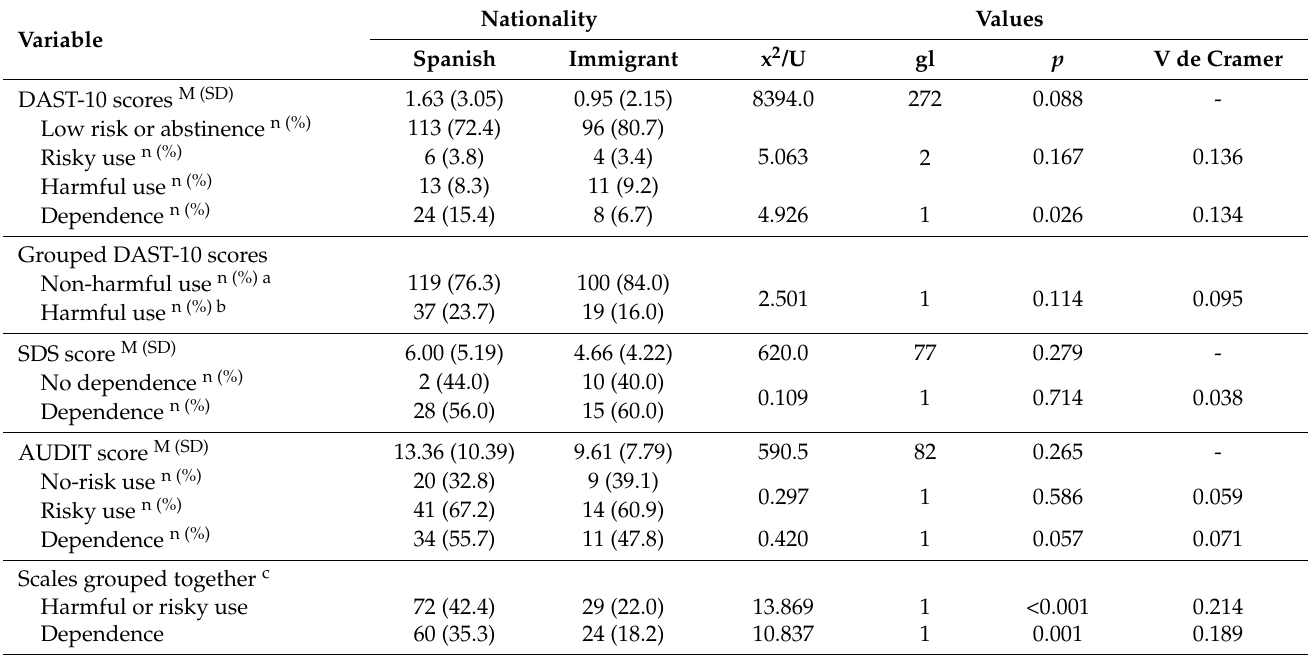
Table 5. Differences by origin among homeless people according to instruments for the assessment of drug and alcohol abuse and dependence (DAST-10, SDS,